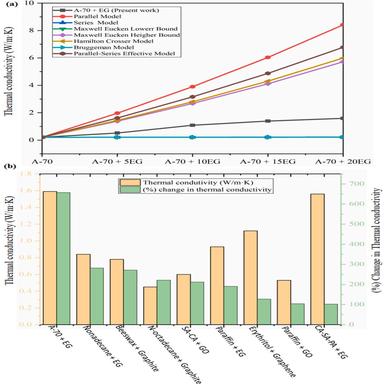
Schematic (a) thermal conductivity of a SS-PCM composite with different numerical models, and (b) thermal conductivity with the current research work.